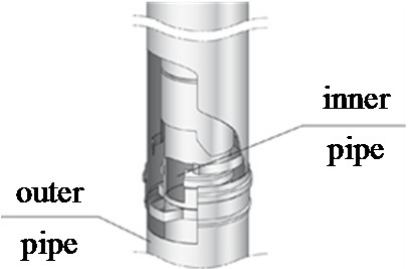
Figure 2. Diagram of a concentric element of the chimney of the wood pellet stove.